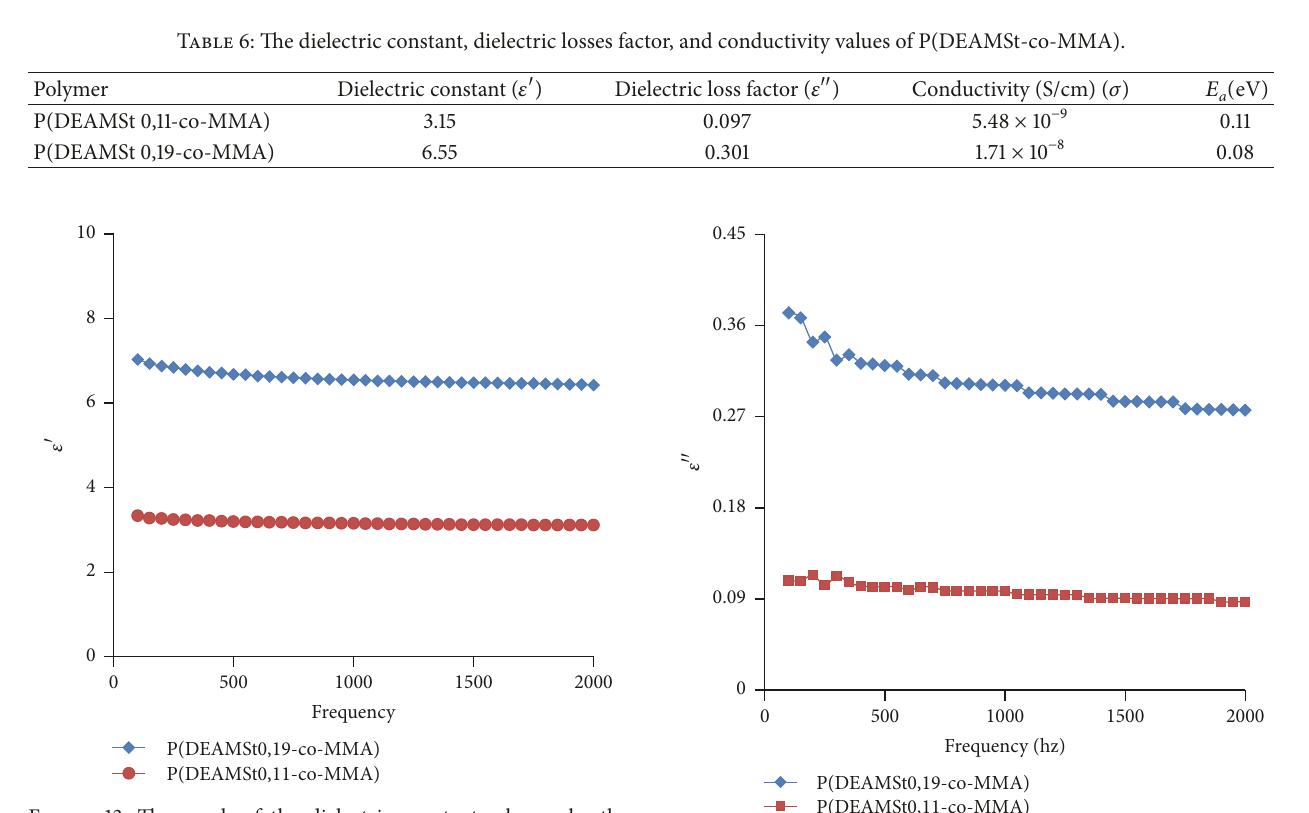
Figure 13: The graph of the dielectric constants change by the frequency of P(DEAMSt0.11-co-MMA) and P(DEAMSt0.19-co- MMA).